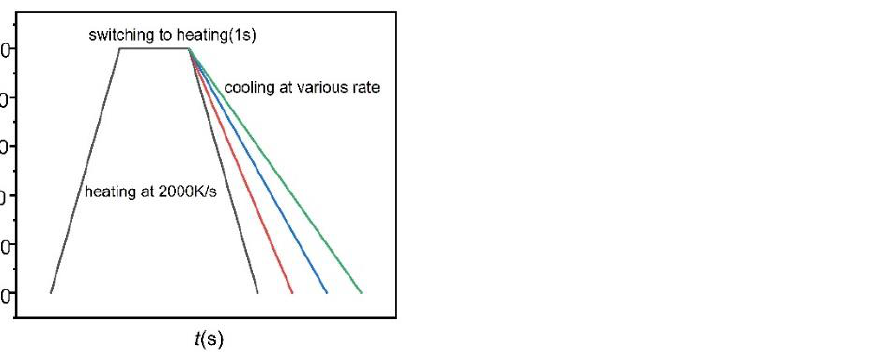
Figure 1. Temperature-time profiles of fast-scan measurements for the samples prepared at different cooling rates for crystallization.